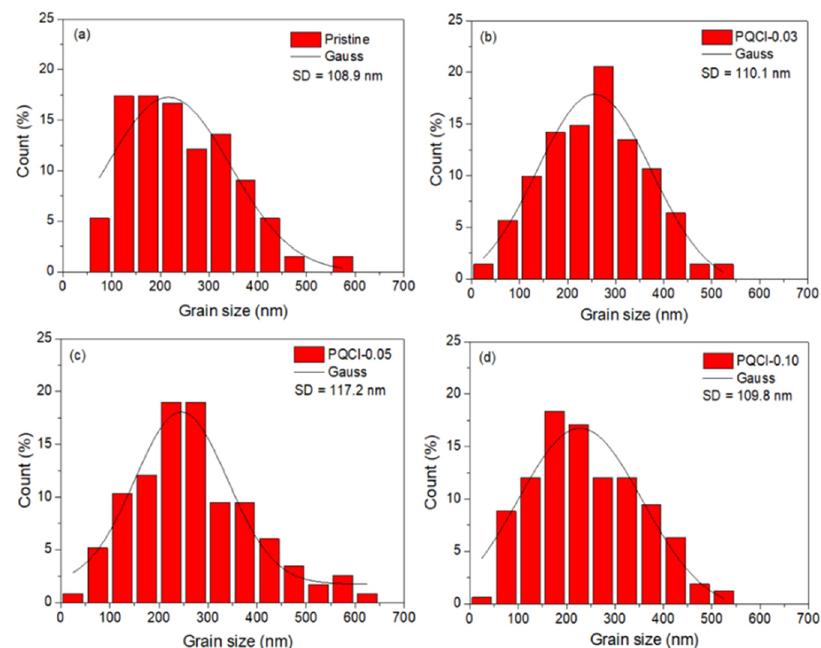
Figure 5. Grain size statistics and Gauss fits of the crystal grain size distributions of ( a ) pristine, ( b ) PQCl-0.03–, ( c ) PQCl-0.05–, and ( d ) PQCl-0.10–based perovskite films (SD: standard derivation).